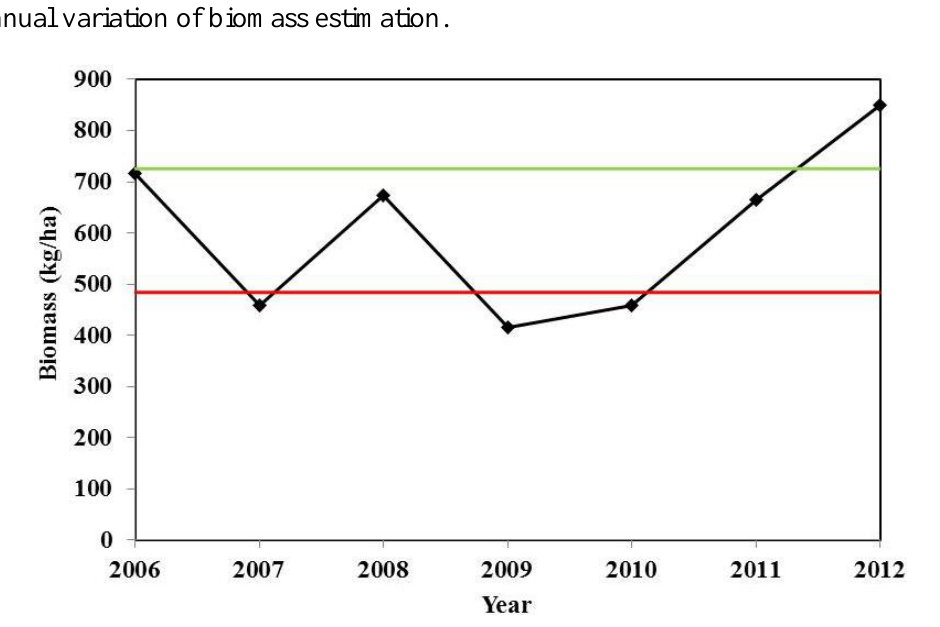
Figure 6. The interannual variation of biomass in different grassland